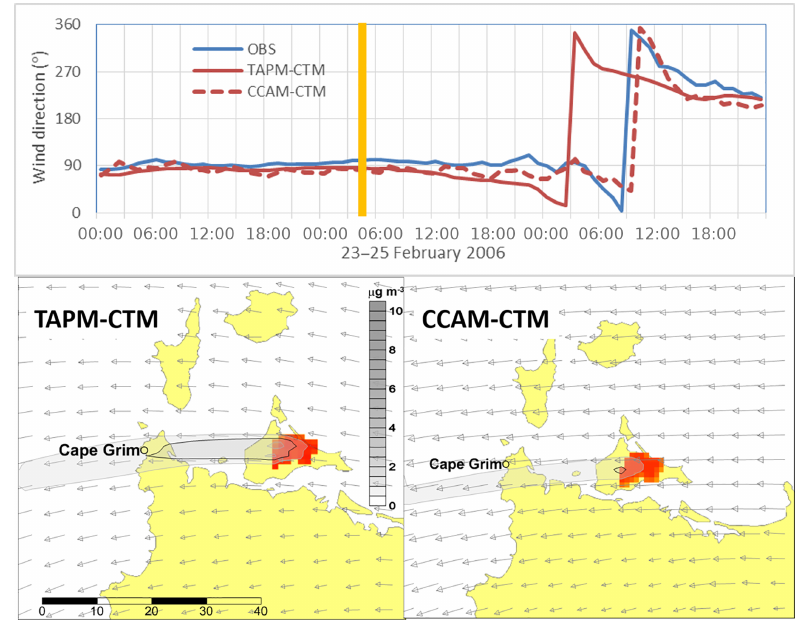
Figure 5. Model concentration isopleth of BC for TAPM–CTM and CCAM–CTM at 05:00 on 24 February during BB2. Arrows are wind vectors. The time series of observed and modelled wind direction for BB2 is shown above with a golden band highlighting the period corresponding to the